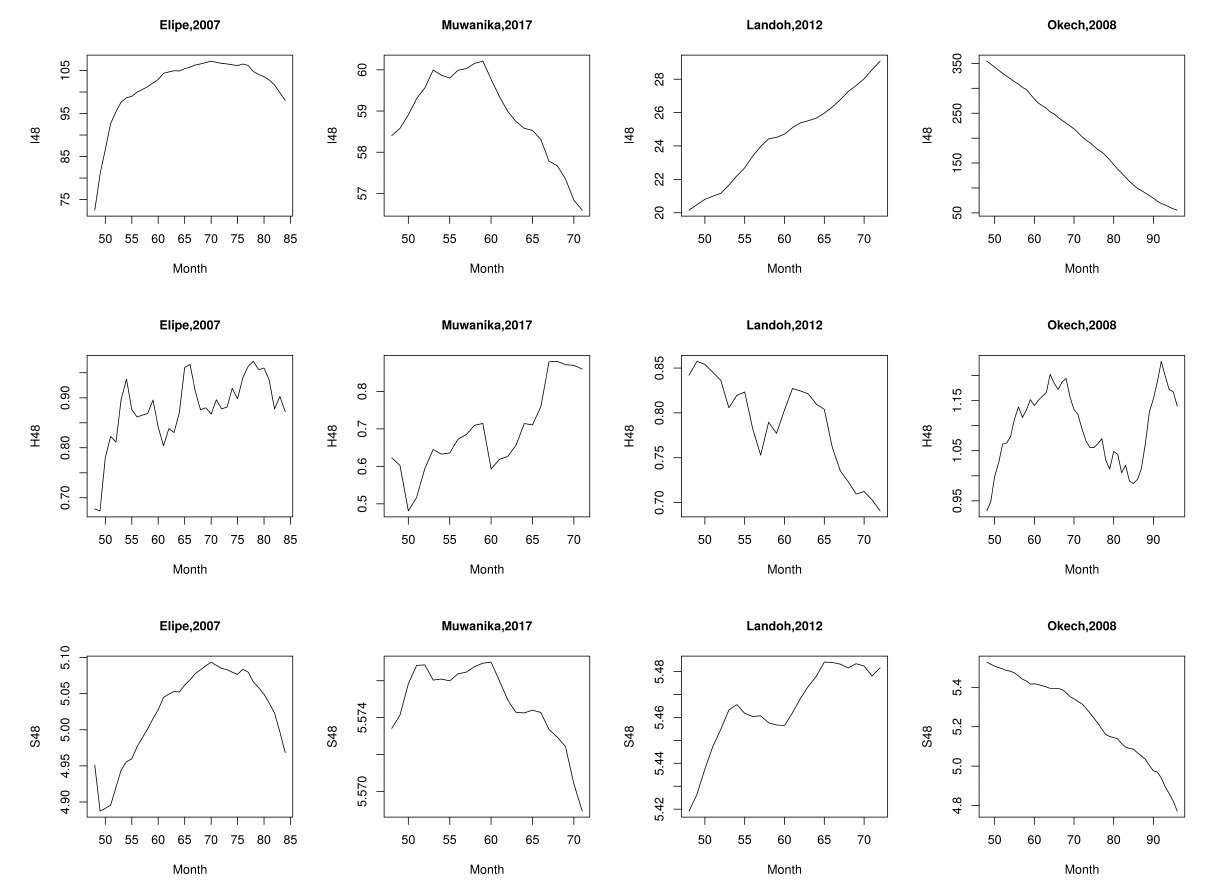
Figure A8. (Cont. Figure A7): Gomez-Elipe et al. (Karuzi in Burundi, 2007) [24], Muwanika et al. (Uganda, 2017) [26], Landoh et al. (Est Mono district in Togo, 2012) [25], and Okech et al. (Kenya, 2008) [27]. Table A1. Table with the general Hurst exponent (GHE) computed, using Equation (A2), for the entire time series and for q = 1 and q = 2 of the 8 empirical time series.